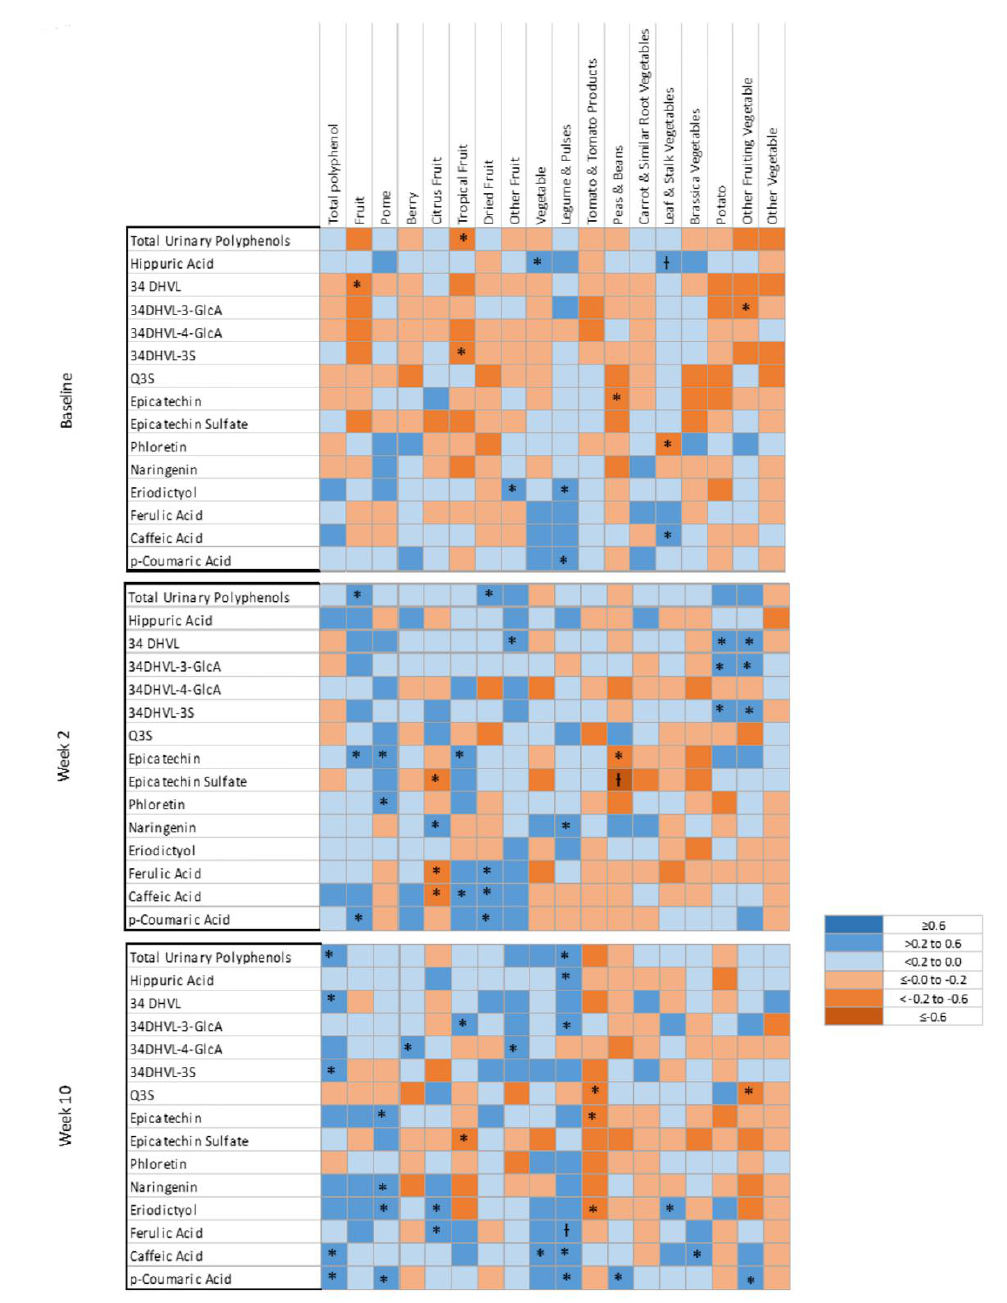
Figure 3. Heat map showing correlations between dietary intake and urinary polyphenol metabolites at baseline, week 2 and week 10. * p < 0.05; Ɨ p < 0.0028. 34DHVL, 5-(3,4-dihydroxyphenyl)-y-valerolactone; 34DHVL-3-GlcA, 5-(3,4-dihydroxyphenyl)-y-valerolactone 3-O-glucuronide; 34DHVL-4-GlcA, 5-(3,4-dihydroxyphenyl)-y-valerolactone 4-O-glucuronide; 34DHVL-3S, 5-(3,4-dihydroxyphenyl)-y-valerolactone 3-sulphate; Q3S, quercetin-3-O-sulfate. 3.4. Linear Mixed Model Associations Between Urinary Metabolites and Total Polyphenol Intakes Using linear mixed models, a statistically significant relationship was identified between total urinary polyphenol and total polyphenol intakes (unadjusted model only). This model suggests that every 1mg of total polyphenol intake results in 16.3nmol/g creatinine excretion of total urinary polyphenols. No other statistically significant relationships were identified (Table 2).